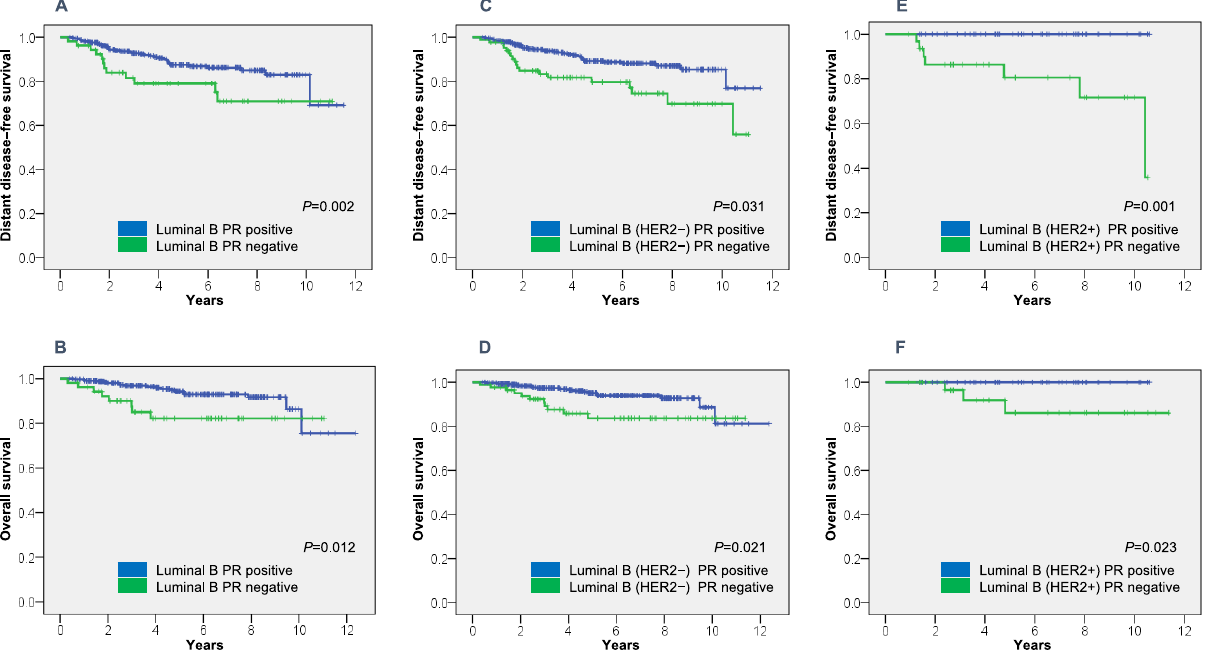
Figure 1 DDFS and OS in 469 women with breast cancer. (A) DDFS in patients with luminal B cancer, (B) OS in patients with luminal B cancer, (C) DDFS in patients with luminal B (HER2–) cancer, (D) OS in